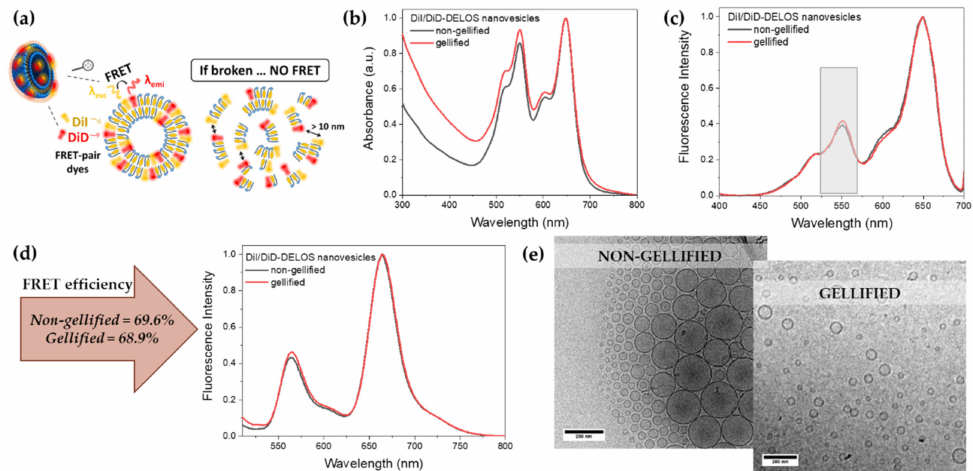
Figure 7. ( a ) Representative image of the presence or absence of FRET phenomena in the whole vs. dissociate DiI/DiD-DELOS nanovesicles, respectively; ( b ) absorption and ( c ) excitation spectra of gellified and non-gellified DiI/DiD-DELOS nanovesicles; ( d ) emission spectra of gellified and non-gellified DiI/DiD-DELOS nanovesicles with their FRET efficiency value; and ( e ) cryo-TEM images of DiI/DiD-DELOS nanovesicles non-gellified and gellified. DiI/DiD-DELOS nanovesicles were prepared using CTAB as surfactant and water as media. Gellified nanovesicles were previously diluted 1:100 in water for an adequate fixation and preservation of the hydrogel sample in the